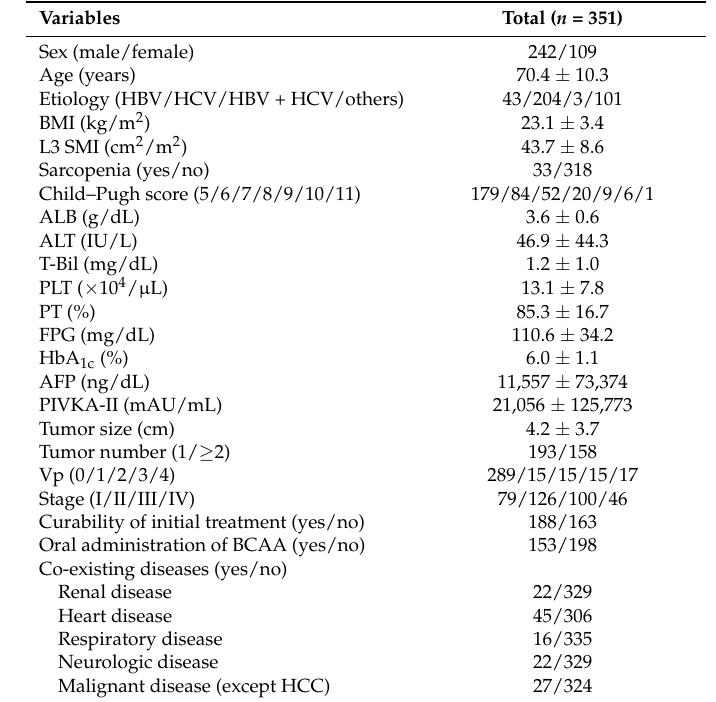
Table 1. Baseline demographic and clinical